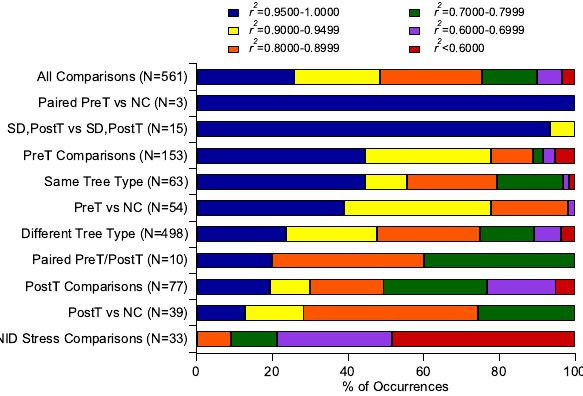
Figure 3. Distribution of correlations classified by type of compar- ison. x axis is the % of total occurrences within a given correla- tion range for each experiment classification. Each horizontal bar denotes the type of comparison where the N value in parentheses refers to the total number of comparisons within that classification. PreT is pre-treatment; PostT is post-treatment; NC is negative con- trol; SD,PostT is post-treatment where treatment and SOA growth experiment occurred on the same day; UNID stress is unidentified